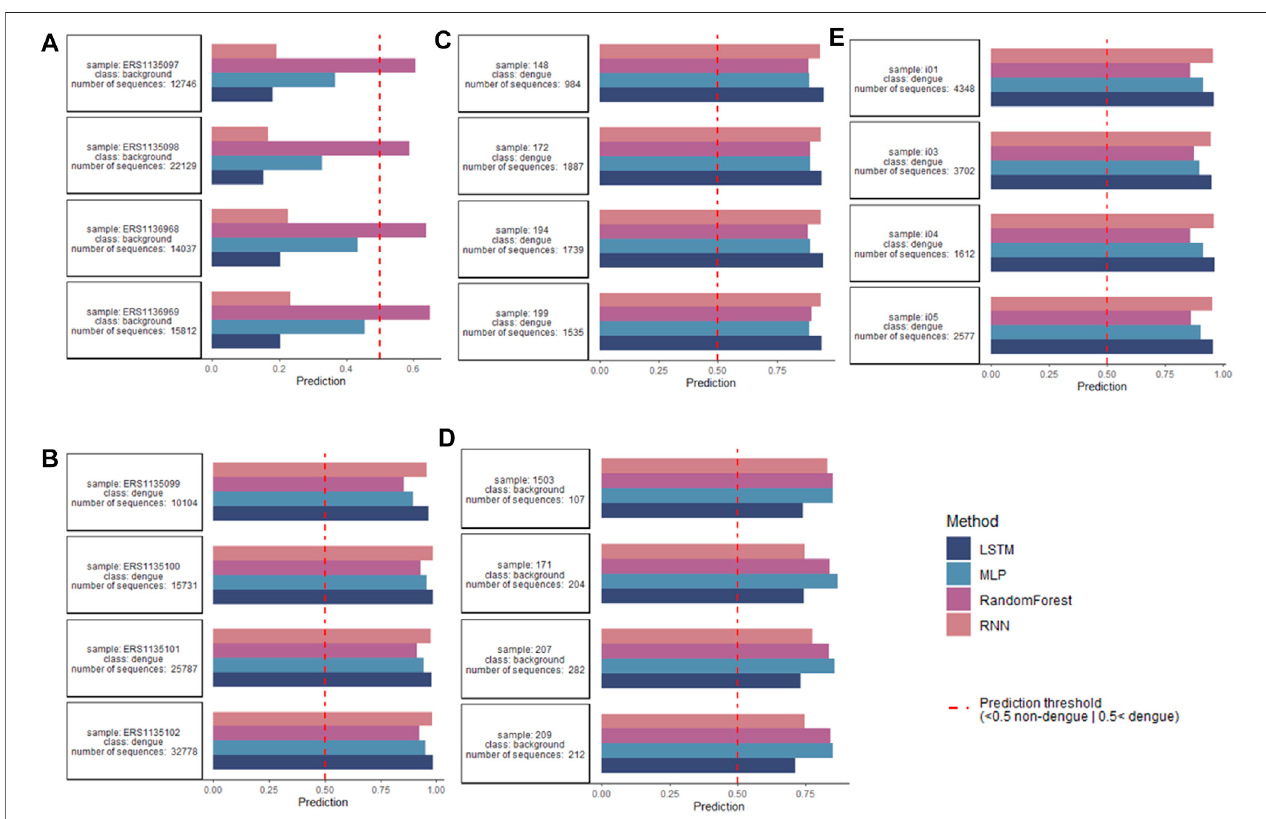
FIGURE 6 | Classi fi cation on repertoire level per used dataset, for readability only four repertoires per class. (A,D) Classi fi cation performed for non-dengue- challenged repertoires found in Parameswaran et al. (2013) and Hwang et al. (2018). While in (A) all repertoires were classi fi ed correctly by the ANN models, in (D) all repertoires were mistakenly classi fi ed as dengue-challenged, likely due to a low number of sequences ( < 1,000) within the repertoires. (B,C,E) Classi fi cation performed for dengue-challenged repertoires found in Parameswaran et al. (2013), Godoy-Lozano et al. (2016); and Hwang et al. (2018) where all repertoires were correctly classi fi ed as dengue-challenged. Sequence-level basis for classi fi cation of dengue repertoires and